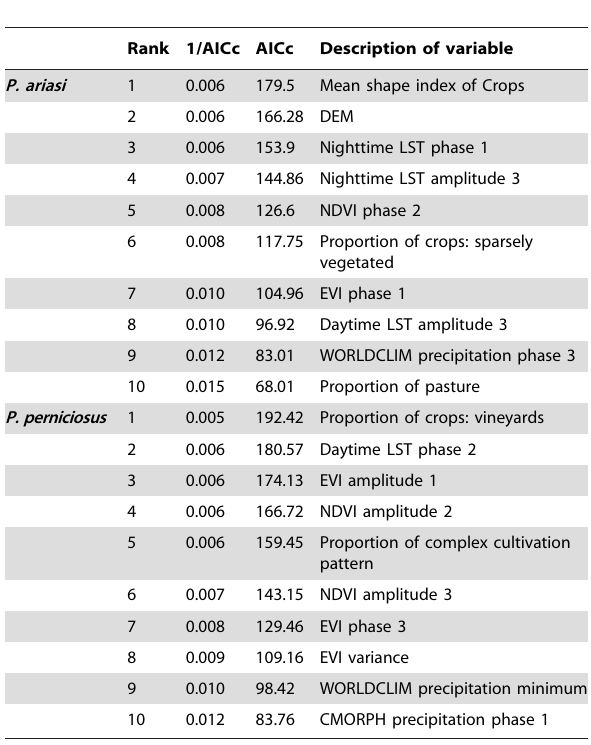
Table 2. Predicting variables that performed best in the final